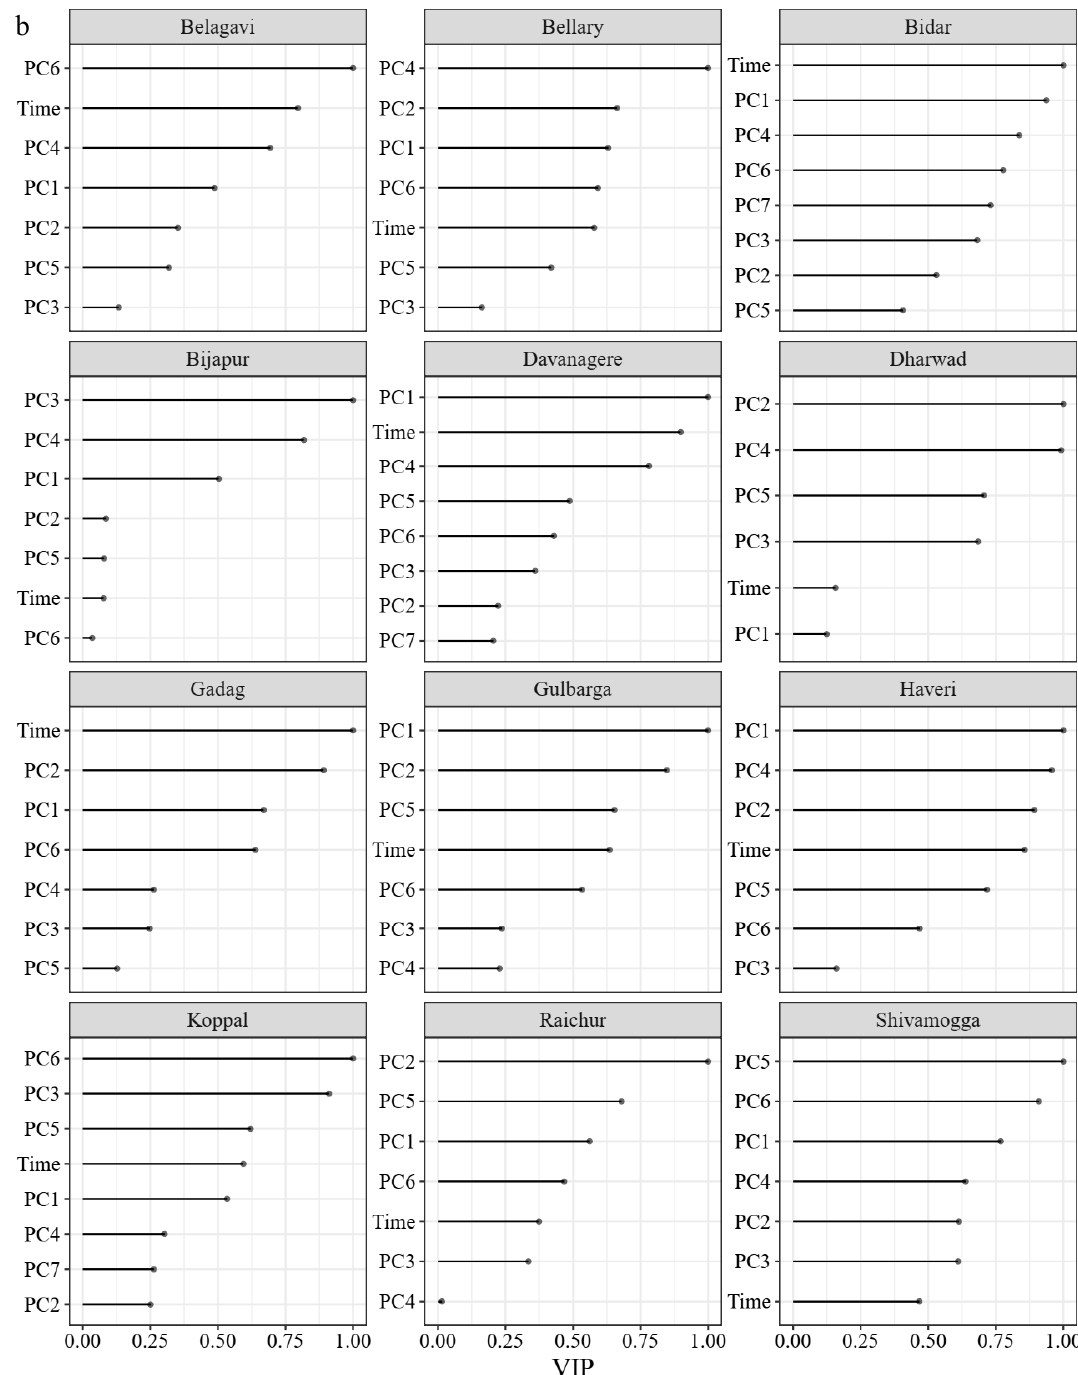
Figure 2. Variable importance of PCA_ANN model without ( a ) and with AET ( b ).